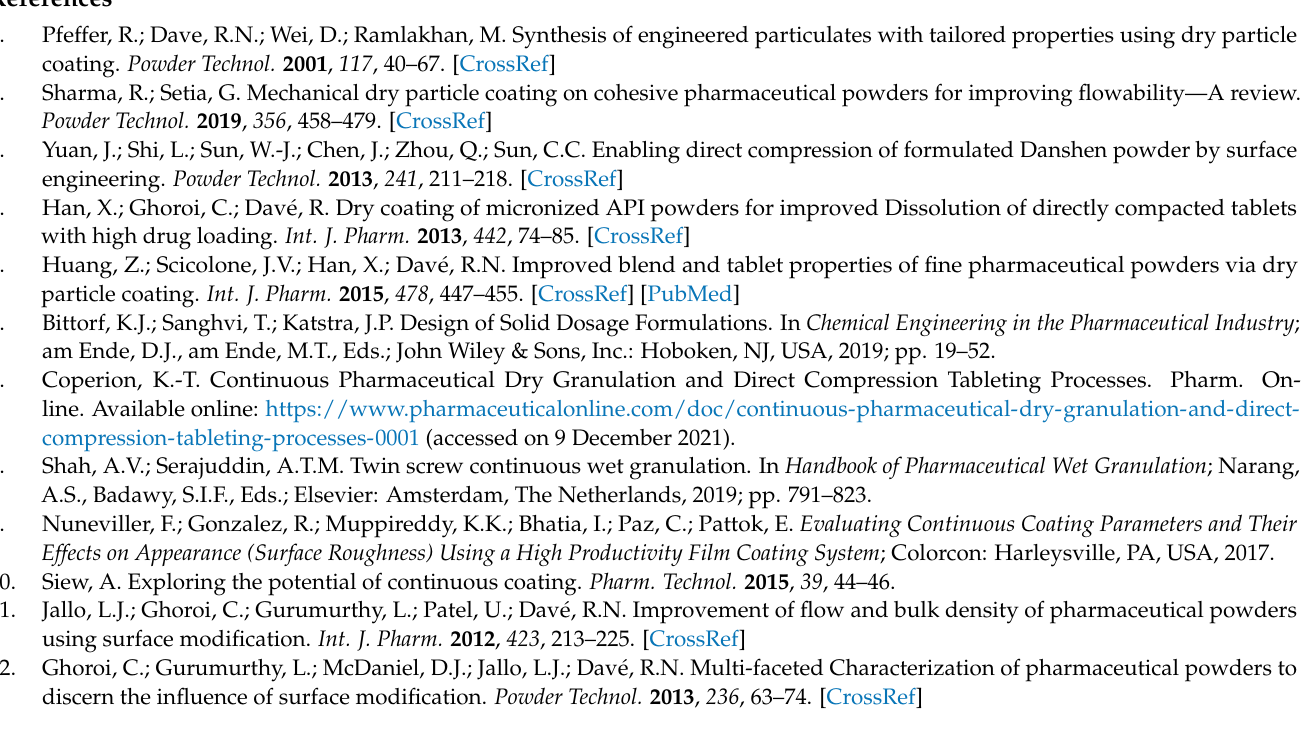
curve of Figure A1 shows the corrected result. The error is null for small particle sizes but for particles close to 100 μ m the height of the peak is underestimated if no correction is made.